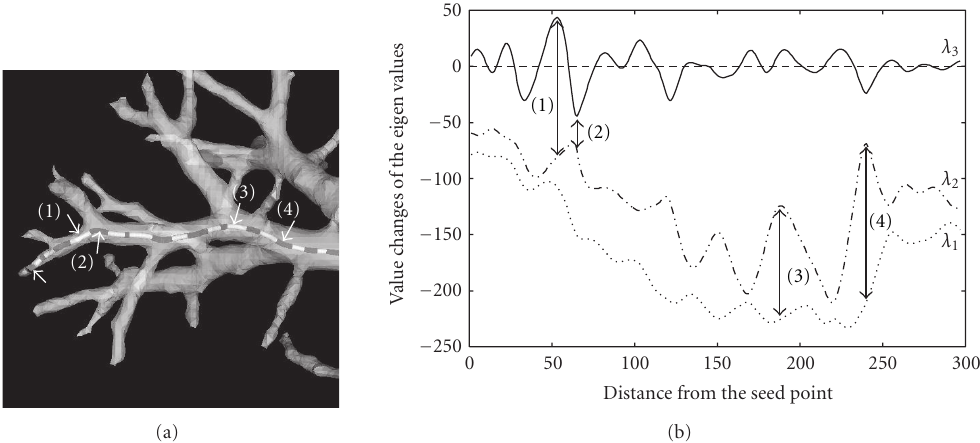
Figure 2: A trajectory of vessel segments and value changes of the eigenvalues along the trajectory. Left-most white arrow in (a) shows the starting point of the trajectory that advances left to right. The trajectory is calculated with fixed σ f = 1. λ 3 oscillates as the front advances and takes negative values close to the junctions indicated by dark gray regions on the trajectory. λ 3 takes large values at location (1) and (2) making absolute value of the ratio λ 3 /λ 2 larger. At locations (3) and (4), the ratio λ 2 /λ 1 becomes small.